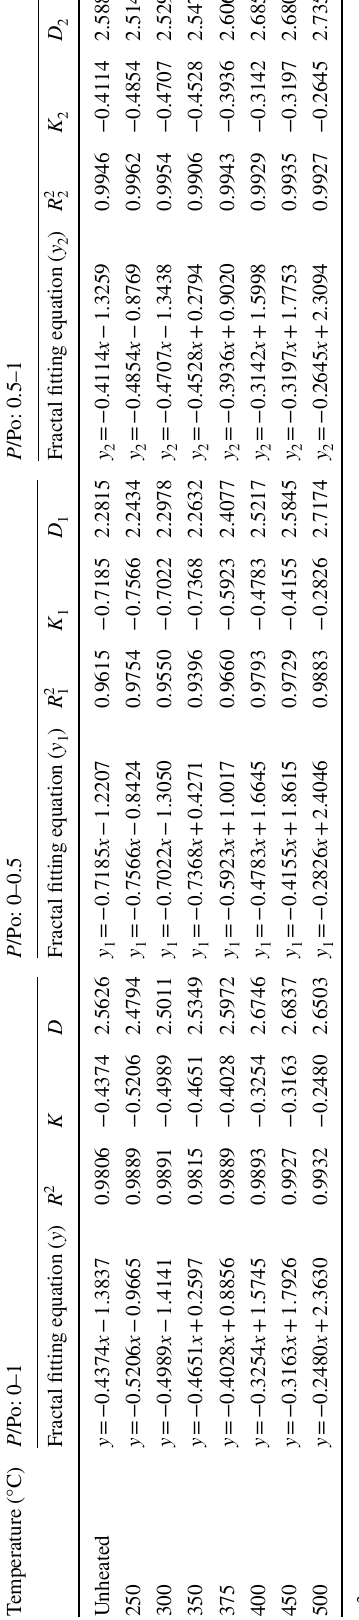
D – D D 1 , 2 and 1 –